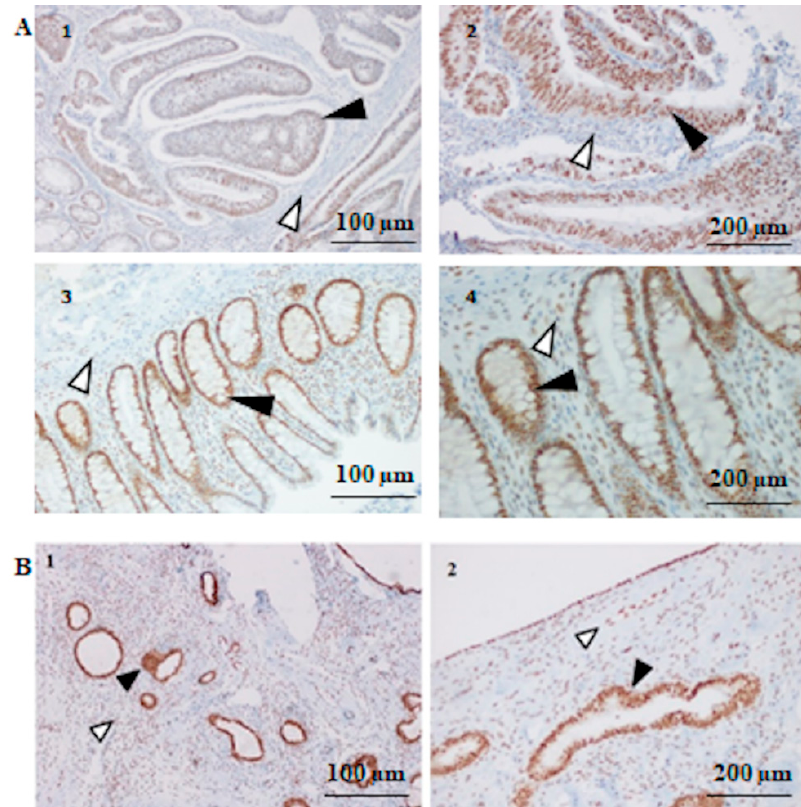
Figure 2. MSH2 immunohistochemistry (IHC) analysis. ( A ) MSH2 IHC results in index patient III-2. (1) Moderate positive IHC in the colon tumor cells (filled arrow heads point) 100 µ m and (2) 200 µ m; (3) strong positive IHC in the normal mucosa cells (filled arrow head point) of the patient 100 µ m and (4) 200 µ m, compared with IHC + internal stromal cells (open arrow head point). ( B ) MSH2 IHC results in patient II-6. (1) Strong positive staining in the endometrial atrophic polyp cells (filled arrow head point) 100 µ m and (2) 200 µ m, compared with IHC + internal stromal cells (open arrow head